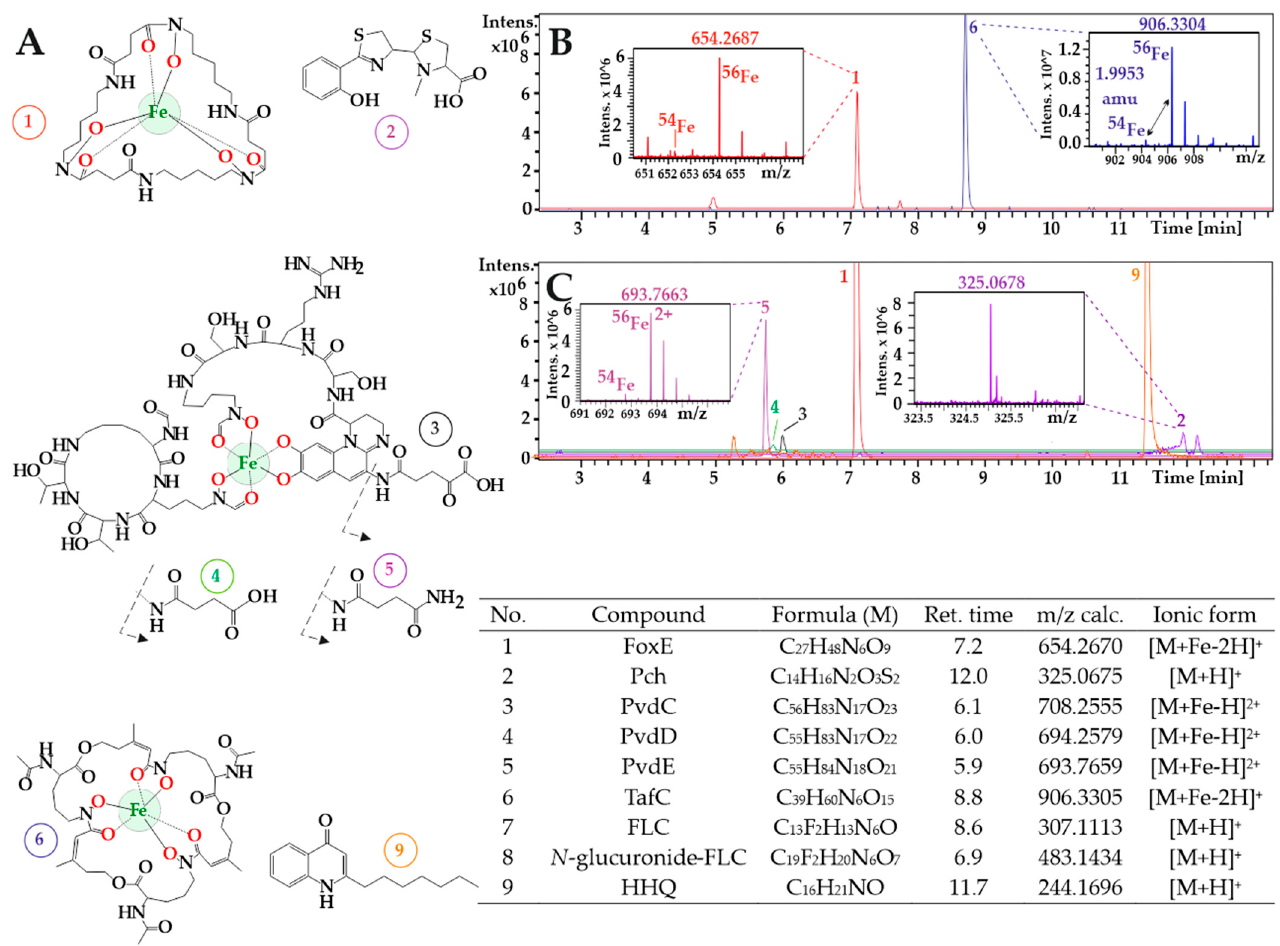
Figure 2. Noninvasive detection of Aspergillus and Pseudomonas biomarkers returned by CycloBranch. ( A ) Chemical structures of the siderophores (1–6) and HHQ (9). Compound numbering is described in the associated table. ( B ) Patient 1’s urine profile compiled from reconstructed ion chromatograms recorded in the low- and high-mass experiments (see Materials and Methods for details). TafC was detected as a singly charged species (m/z 906.3304, see the right inset for Peak 6, indicating the presence of 54 Fe and 56 Fe stable isotopes). The left inset (Peak 1) indicates the isotopic profile of FoxE. ( C ) Patient 1’s breath condensate profile sampled on the same Day 12 of illness with a mixture of doubly charged pyoverdines. Peak 5 in the left inset is represented by an isotopic pattern, indicating two charges ( 54 Fe/ 56 Fe isotopes are separated by approximately one Dalton). The right inset belongs to pyochelin singly protonated molecule. M in the table stands for neutral molecule; Ret. time, retention time. Fluconazole and its glucuronide structures are reported in Supplementary Materials Figure